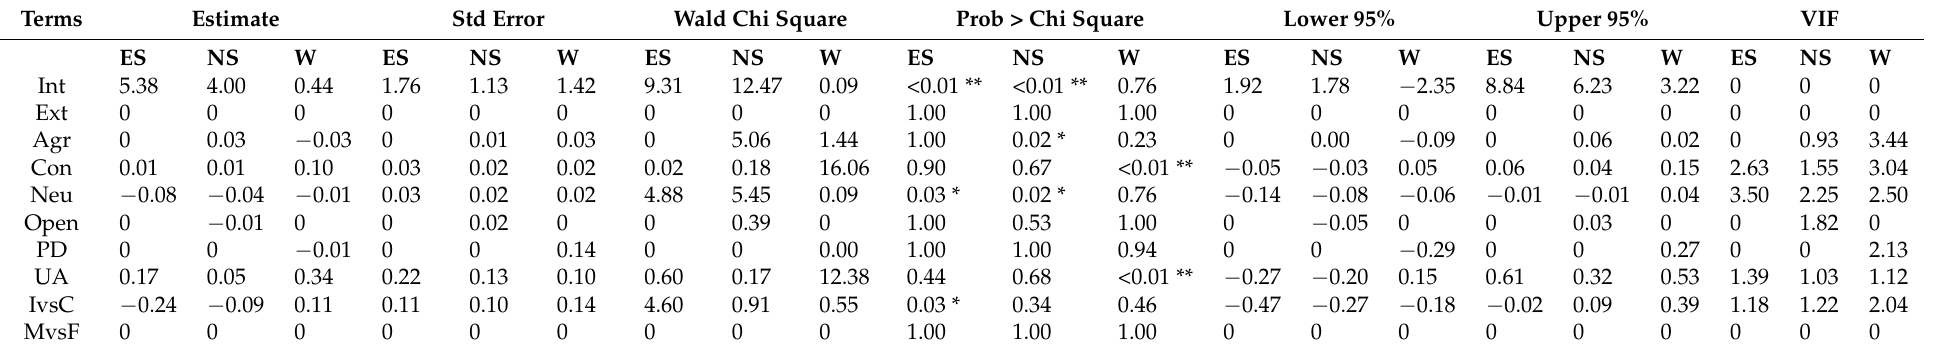
Table 7. Parameter estimates of predictors, Wald statistics, 95% confidence interval and variance inflation